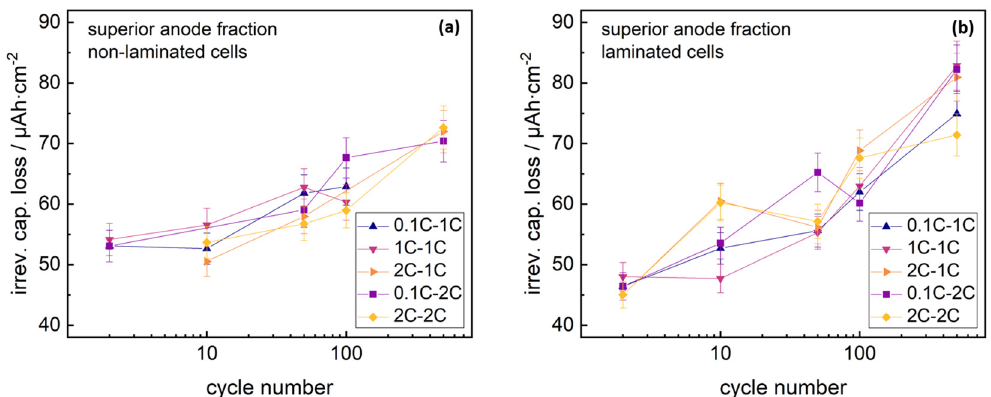
Figure 5. Comparative lithium fractions in graphite anodes, comparing ( a ) rinsed graphite anode (non-laminated) and ( b ) rinsed anode / separator stack (laminated), detected post-mortem with NDP; data analysis restricted to comparative depth sector within all graphite anodes.